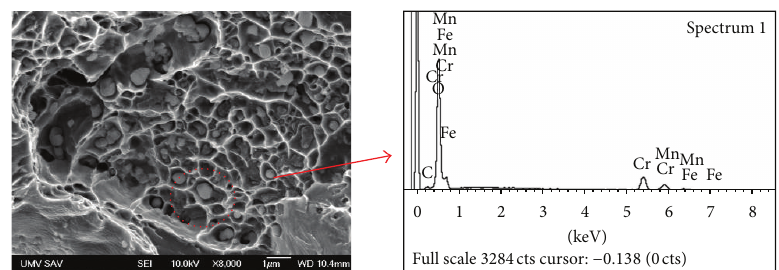
Figure 10: EDX analysis of oxides showed the presence of 34 wt.% of oxygen, 23wt.% of chromium, and 11% of manganese and 32 wt.% of iron.